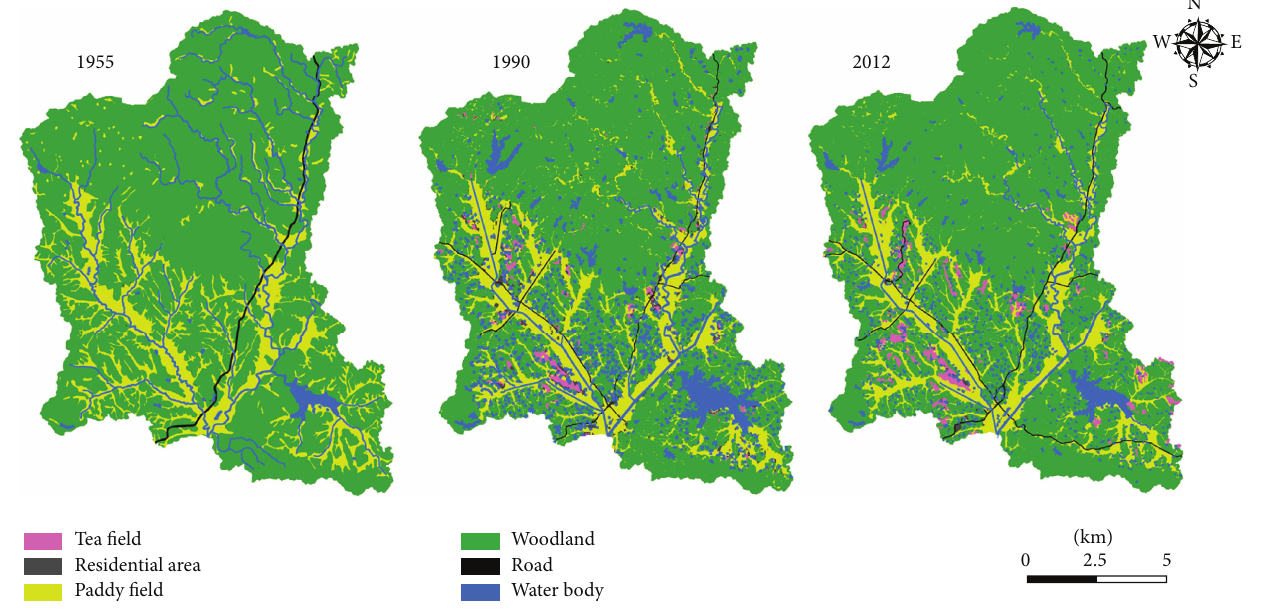
Figure 1: Land-use distributions during 1955–2012.